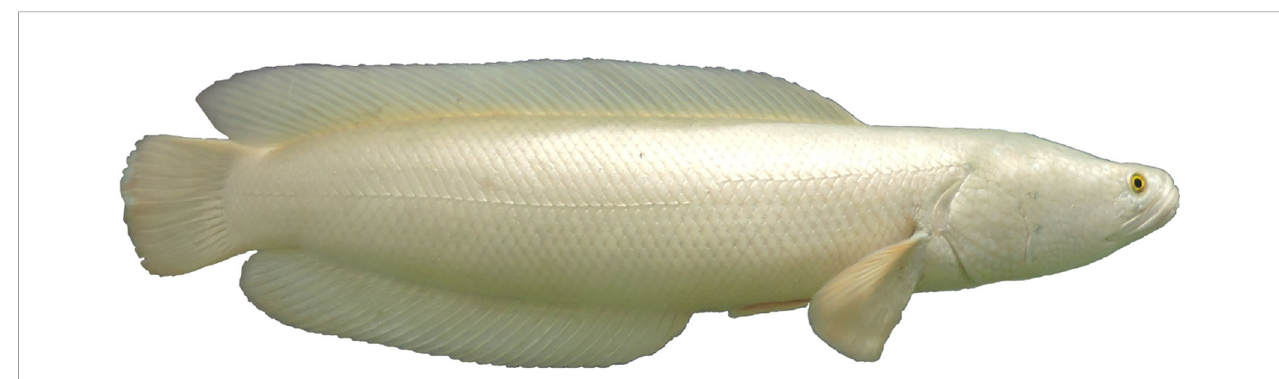
FIGURE 1 | A picture of the albino northern snakehead C. argus var. for the reference genome